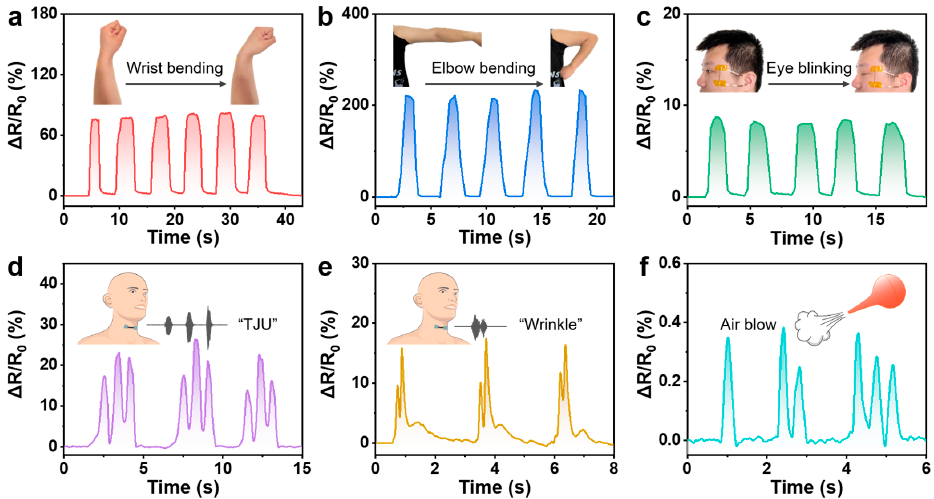
Figure 7. ( a ) Relative resistance change against wrist bending ( a ), elbow bending ( b ), eye blinking ( c ), speaking ( d , e ), and air blow ( f ). speaking ( d , e ), and air blow ( f